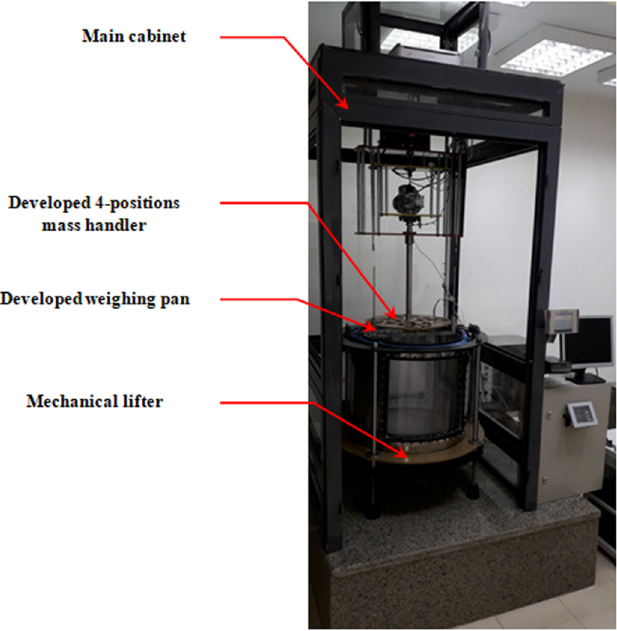
Fig. 1. A photograph for the (DHWS-NIS) on its fi nal